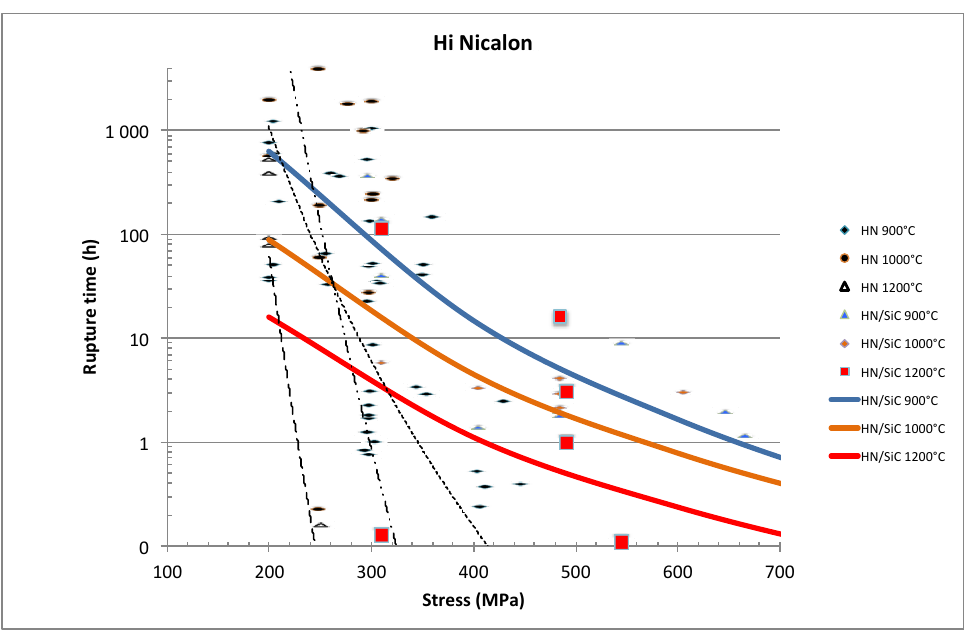
Figure 8. Comparison of static fatigue behavior of dry tows ( 900 °C; 1000 °C; 1200 °C) and Hi Nicalon/SiC minicomposites at elevated temperatures >900 °C.